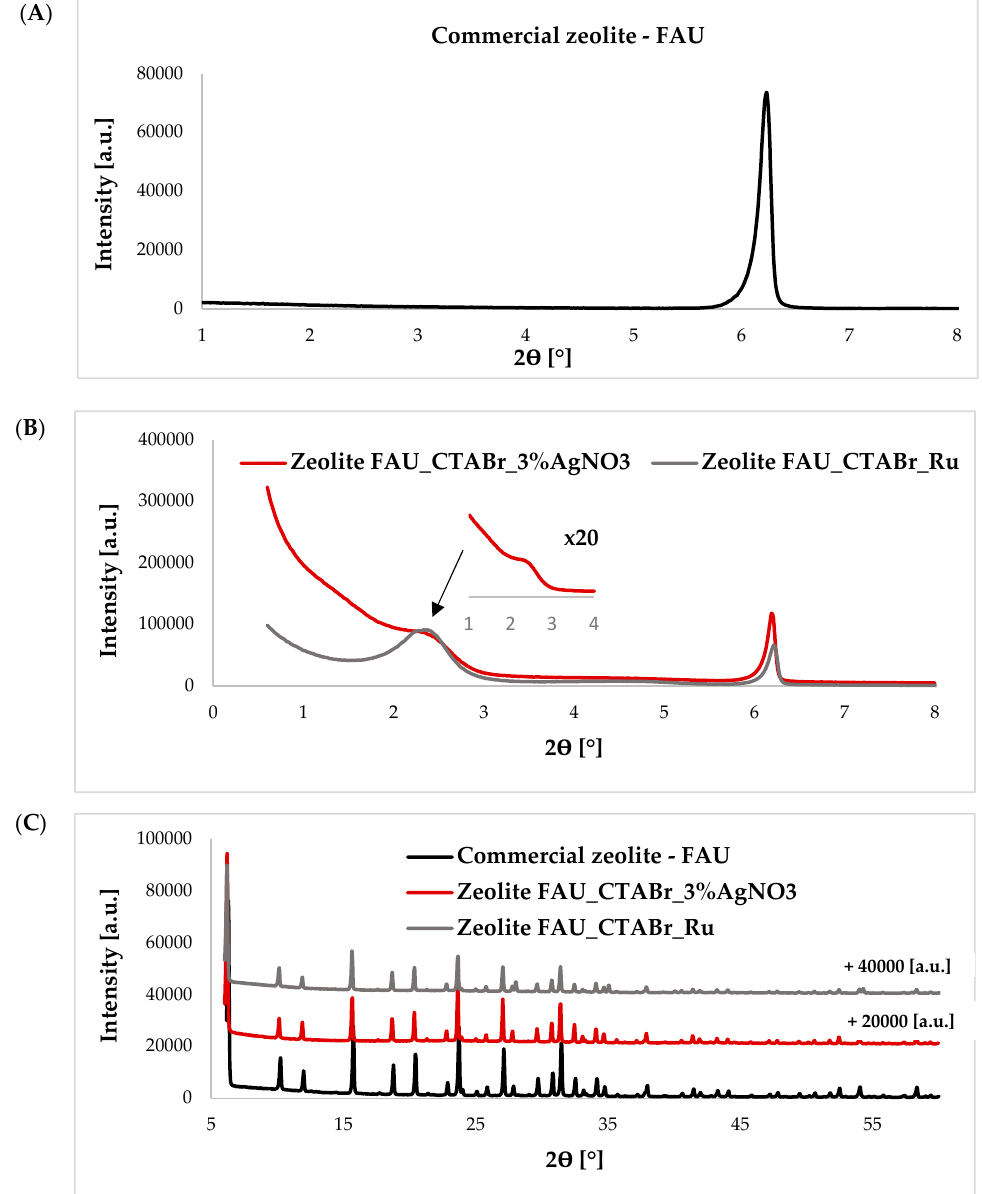
Figure 1. Diffractograms of ( A ) FAU-type commercial zeolite in the low-angle range, ( B ) hierarchical materials derived from FAU-type commercial zeolite in the low-angle range, ( C ) hierarchical materials based on FAU-type commercial zeolite in the wide-angle range.